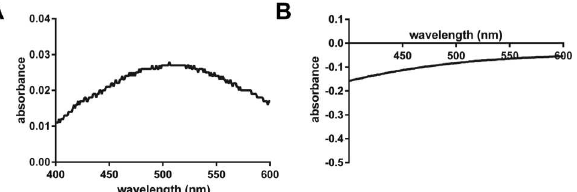
Fig 4. Differenceabsorption spectraof WT ALKBH7 and its R191Q variant. The spectra of the anaerobic proteins(0.3 mM) were recordedin the presenceof 2 mM α -kg and 100 μ M Fe(II). The difference spectra were obtainedby subtractingthe spectra for proteinswith α -kg, but without the metal. A , WT ALKBH7; B , R191Q